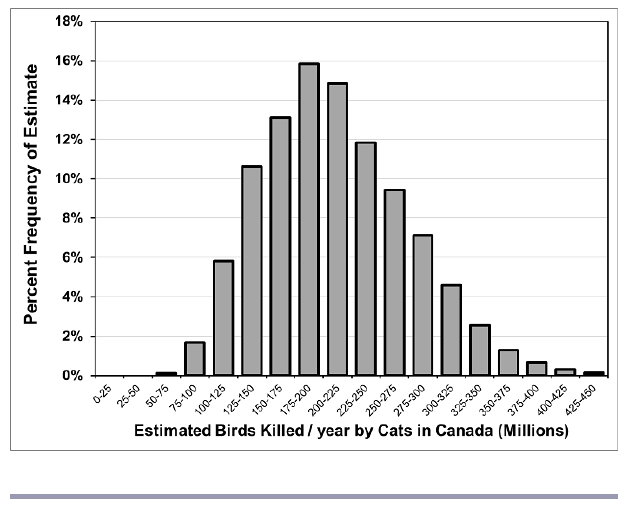
Fig. 2 . Estimates of the number of birds killed per year by cats in Canada, shown as a frequency distribution across all iterations (see Methods).